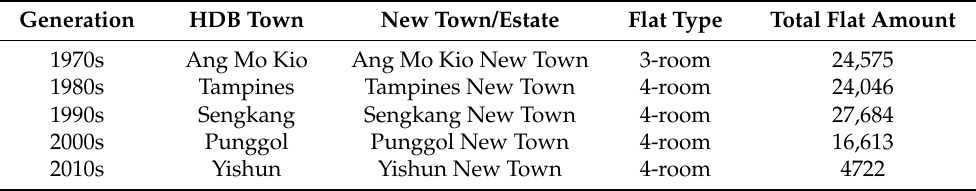
Table 1. Representative HDB towns with typical flat types for case